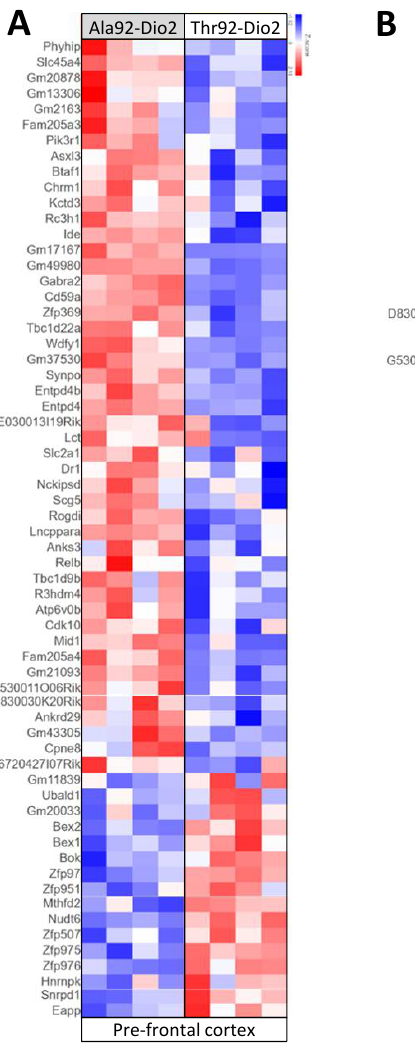
(47-up and 16-down regulated genes) differentially expressed in Ala92-Dio2 pre-frontal cortex that overlapped in male and female mice; ( B ) same as A, except that shown is 34 genes (23-up and 11-down regulated genes) that overlapped in the hippocampus of male and female mice; and ( C ) Same as A, except that shown is 29 genes (23-up and 6-down regulated) overlapped in the pre-frontal cortex and hippocampus of male and female mice; relative gene expression is indicated by the degree of color saturation (red: higher level; blue: lower